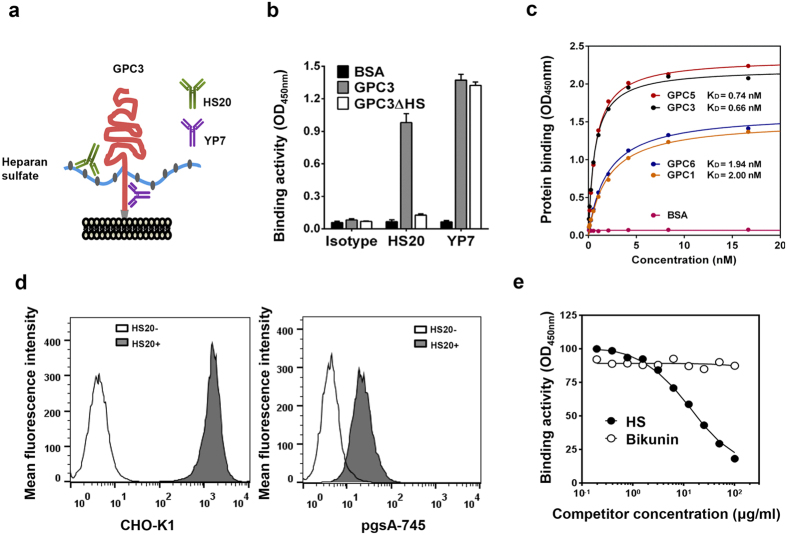
The binding properties of HS20 monoclonal antibody.(a) The schematic structure of GPC3, the human monoclonal antibody HS20 recognizing the heparan sulfate chains on GPC3 and the mouse monoclonal antibody YP7 recognizing a C-terminal region of the GPC3 core protein. (b) HS20 did not bind the mutant GPC3 without heparan sulfate chains (GPC3ΔHS). ELISA results showed the binding properties of HS20 and YP7 on wild type GPC3 and GPC3ΔHS. BSA was used as the negative antigen control. Values represent mean ± SD, t-test. (c) The binding property of HS20 to various glypicans. ELISA results show the binding affinities of HS20 for GPC1, GPC3, GPC5 and GPC6. The X-axis represents the concentration of HS20, while the Y axis indicates protein binding as determined by the OD450 nm. (d) HS20 lost binding capacity on the cells without heparan sulfate. Flow results showed the binding of HS20 for CHO-K1 cells and pgsA-745 cells, which lack the ability to produce HS and CS. (e) HS but not CS inhibited HS20 binding for GPC3. A competitive ELISA where HS20 (5 μg/ml) was pre-incubated with increasing concentrations of HS or bikunin (CS) for 30 minutes, and then added to an ELISA plate to detect the binding to GPC3.